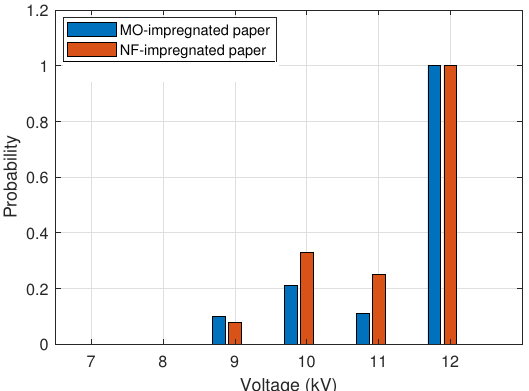
Figure 11. Probability of breakdown in impulse tests.